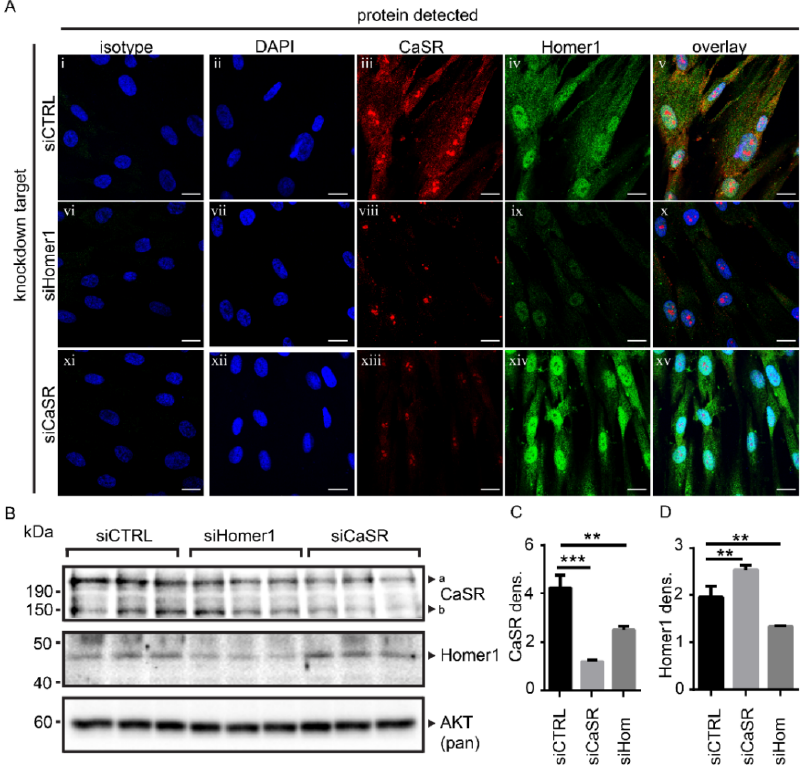
Figure 2. The protein levels of Homer1 and CaSR were linked in osteoblasts in vitro ( A ) ( i – xv ) Confocal microscopy of osteoblasts transfected with a non-directed control siRNA (siCTRL, ( i – v )) or siRNA to Homer1 (siHomer1, ( vi – x )) or CaSR (siCaSR, ( xi – xv )). Cells stained for Homer1 (green), CaSR (red) in combination with nuclear counterstain 4 ′ ,6-diamidino-2-phenylindole (DAPI) (blue). The combined channels of CaSR, Homer1 and DAPI is shown in v , x , xv for each silenced condition (overlay). The combined isotype control stain is shown in i , vi and xi for each silenced condition (isotype). 63× objective, Scale bar = 10 μ m. ( B ) Western blot of CaSR, Homer1 or total AKT (loading control) from total osteoblast lysates of cells 48 h post transfection with siRNA to Homer1 (siHomer1), CaSR (siCaSR) or control sequence (siCTRL)–each from triplicate wells (individual wells run in individual lanes); “a” the higher molecular weight CaSR band is most likely heterodimerized CaSR [20]; “b” is the normal glycosylated molecular mass for CaSR ~150 kDa. ( C , D ) Densitometry of triplicate bands shown in “B” for ( C ) CaSR, or ( D ) Homer1 protein levels. ** p < 0.01, *** p < 0.001. 2.3. Homer1 Protein Expression Was Increased in the Long Bones of Osteoblast-Specific CaSR Knockout Mice